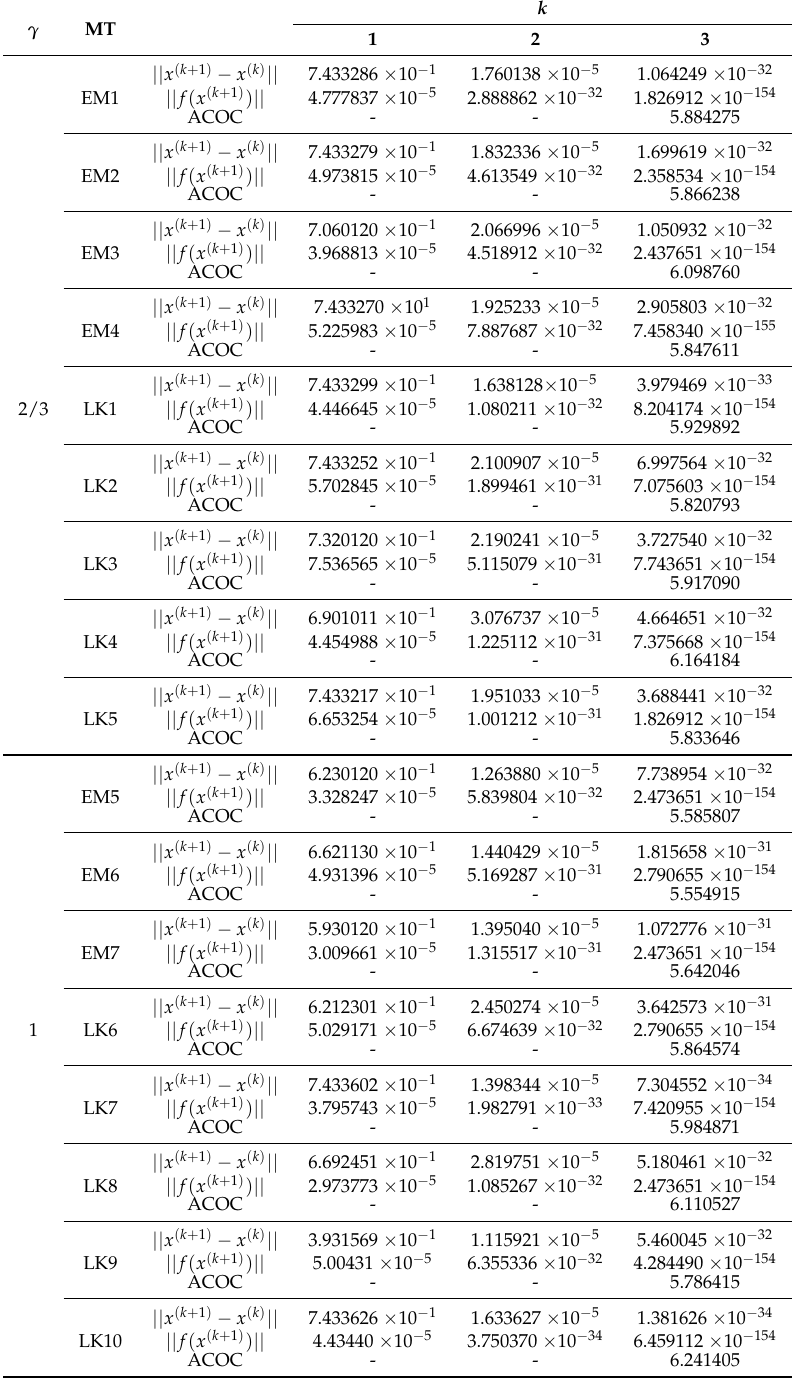
Table 8. Convergence results of Test Example